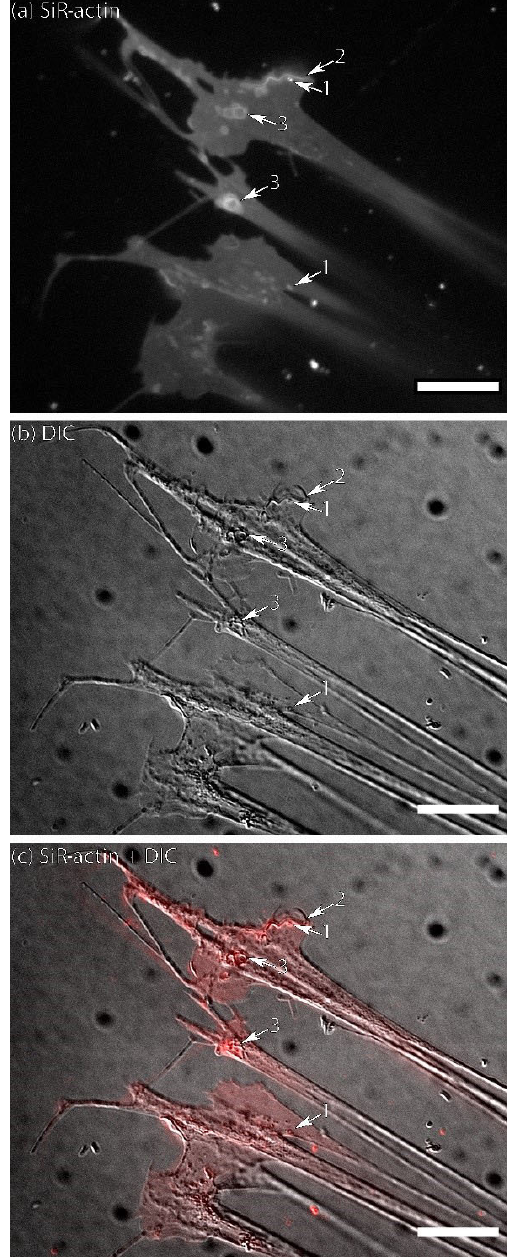
Figure 1. Flattened lamellipodia of living Ammonia sp. attached to glass: (a) fluorescence of SiR-actin-labelled structures, (b) DIC im- age of the same area, and (c) merged image of fluorescence and DIC channels (since the reticulopodia were moving, the DIC image is slightly shifted in relation to fluorescent one). The numbers in- dicate the following objects: 1 – actin-labelled granules (ALGs); 2 – linear SiR-actin-labelled structures; 3 – SiR-actin-labelled rings. Note the weak but non-uniform SiR-actin labelling following all membranous surfaces of pseudopodial structures. The linear struc- ture (2) was subsequently transformed into a ring structure (see Movie S1). Structures corresponding to ALGs, SiR-actin-labelled rings, and linear structures can be seen in DIC image. Conventional fluorescence images were obtained with a Zeiss Axio Observer Z1 (scale bar 20µm).